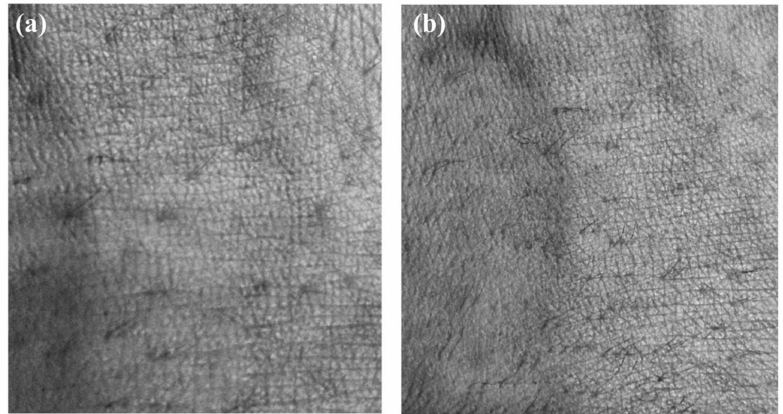
Figure 12. The overlap image of the reference and shift image obtained when the baseline was 10 mm. ( a ) Overlap image acquired by the working distance 60 mm, ( b ) overlap image acquired by the working distance 80